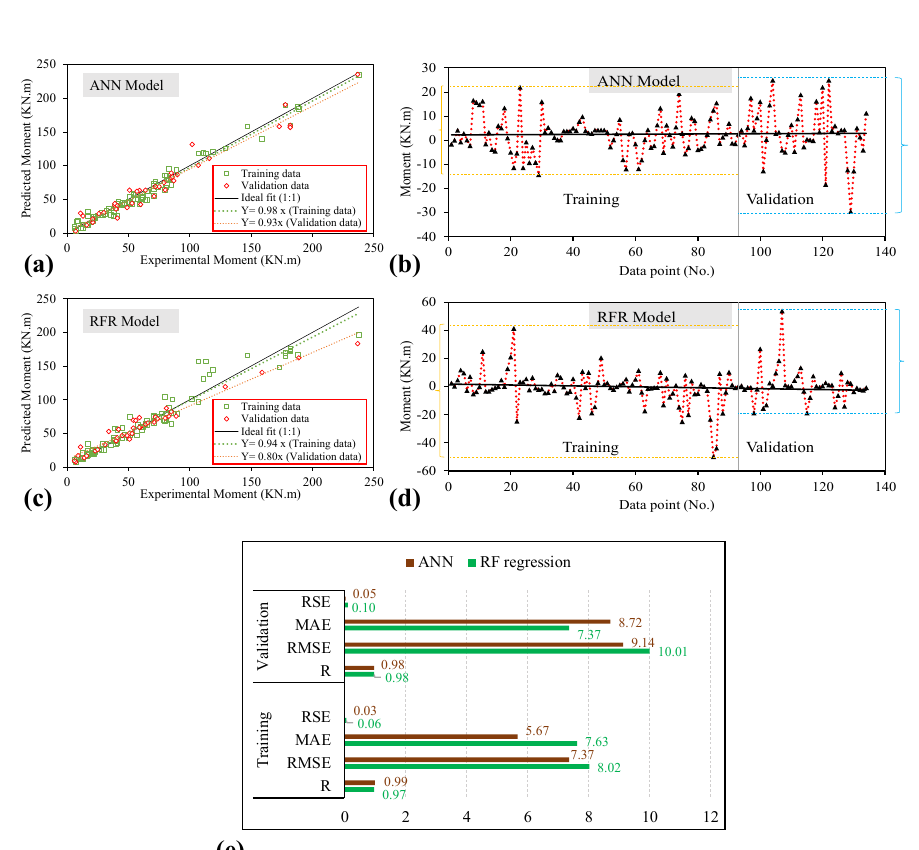
Figure 2. ( a,c ) Comparison of experimental and predicted results, ( b , d ) Error Analysis of the proposed models, and ( e ) Performance indices values for training and validation datasets, in case of ANN and RFR modeling.